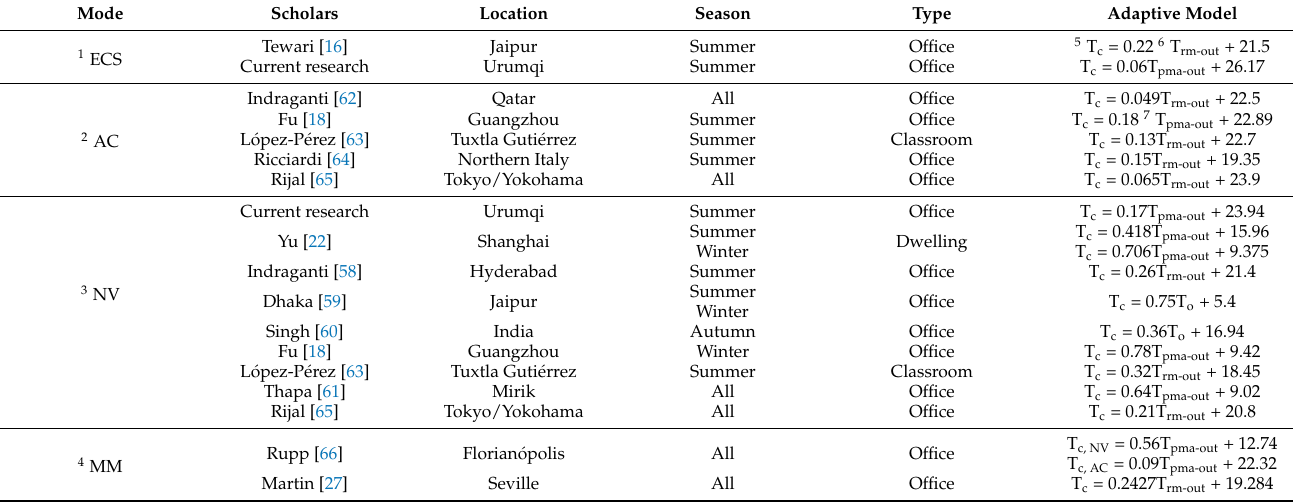
Table 7. Comparison of adaptive model with previous research using different